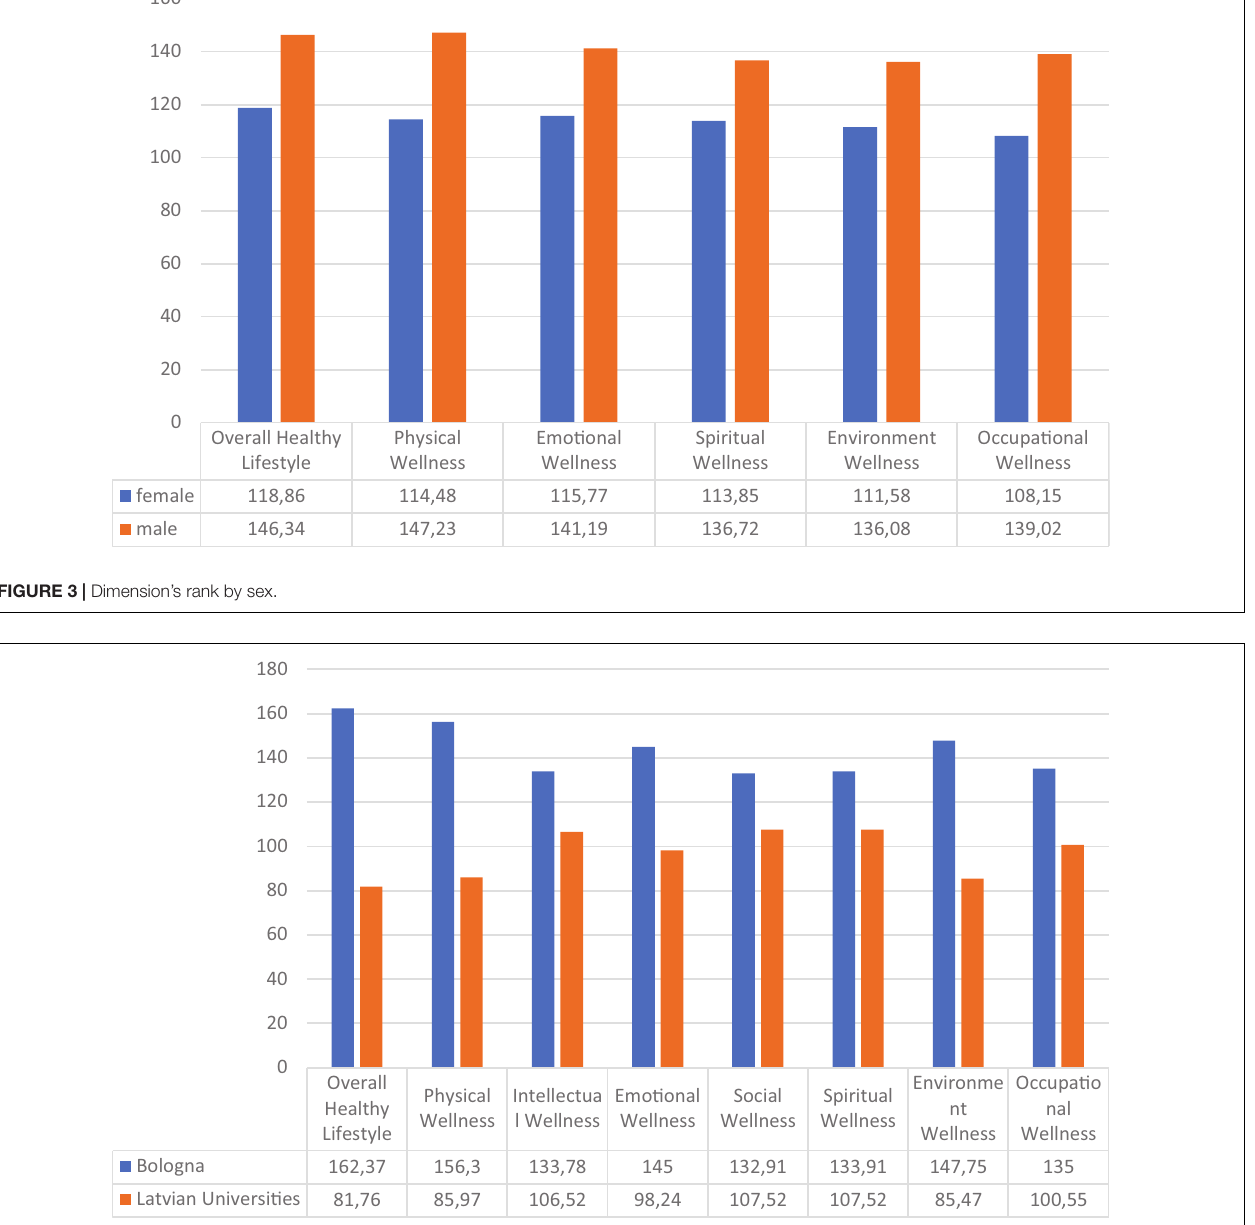
FIGURE 4 | Bologna and Latvian students